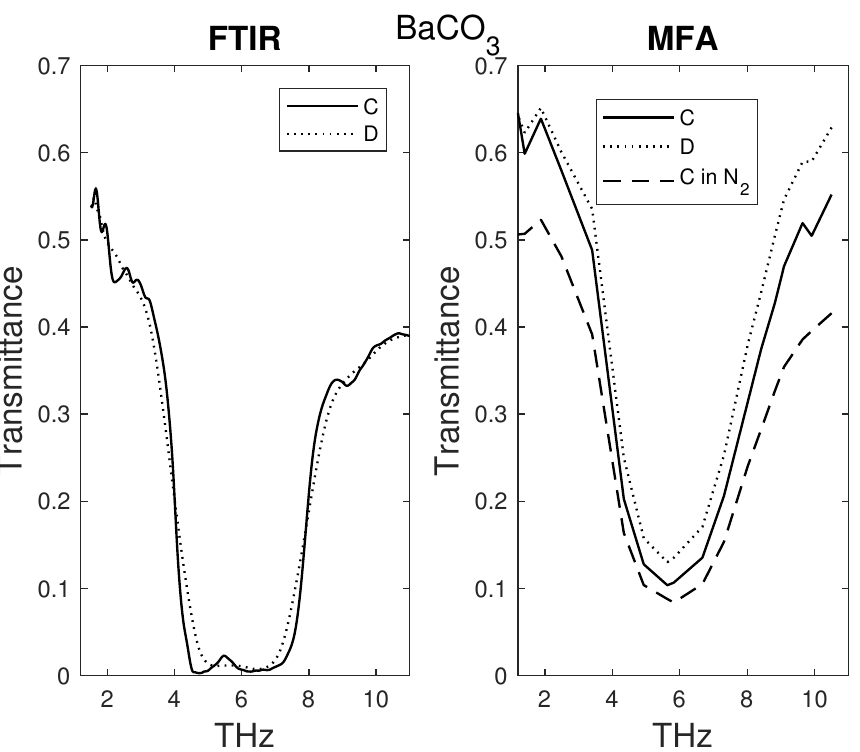
Figure 3. Comparison on two samples C and D of BaCO 3 using Fourier Transformer Infrared Spectrometer (FTIR) ( left ) and Metasurface Filters Apparatus (MFA) right ).